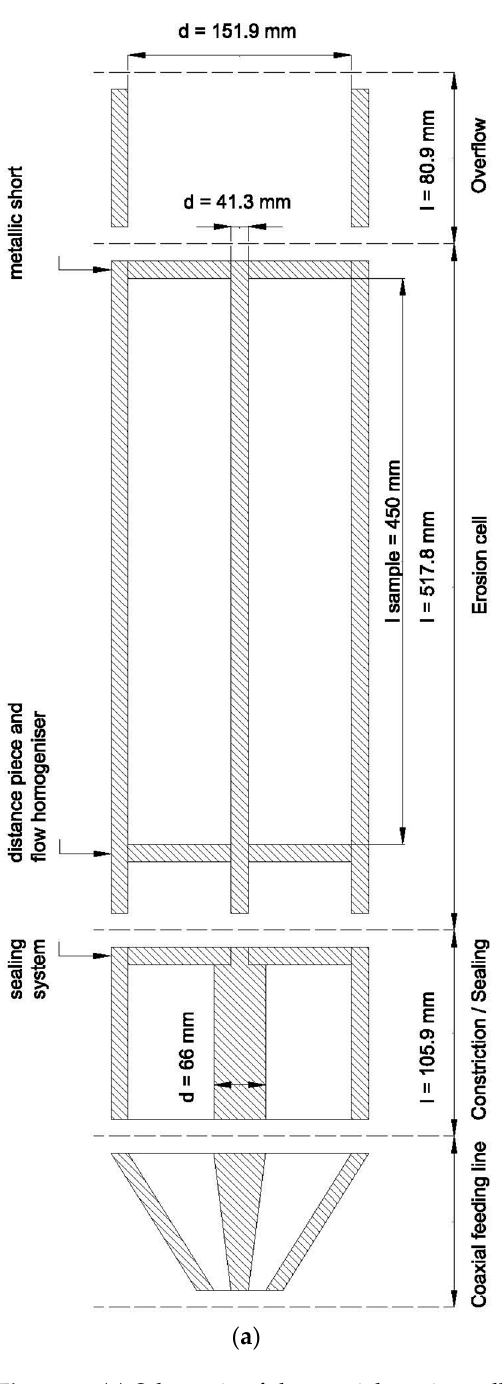
Figure 2. ( a ) Schematic of the coaxial erosion cell (not to scale); ( b ) photograph of the cell on the right: Pressure transducers are visible on the left hand side of the photograph and the inner conductor through the inspection window.